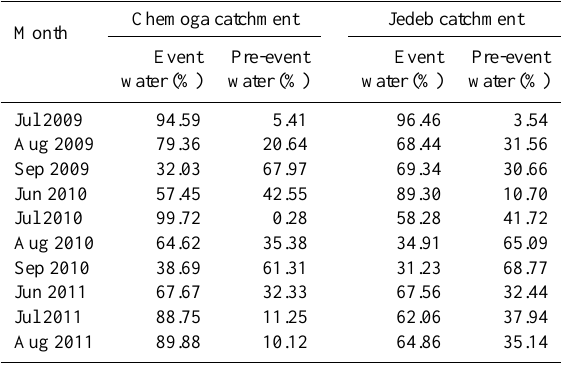
Table 4. Proportion of runoff components in the Chemoga and Jedeb catchments during the wet season.